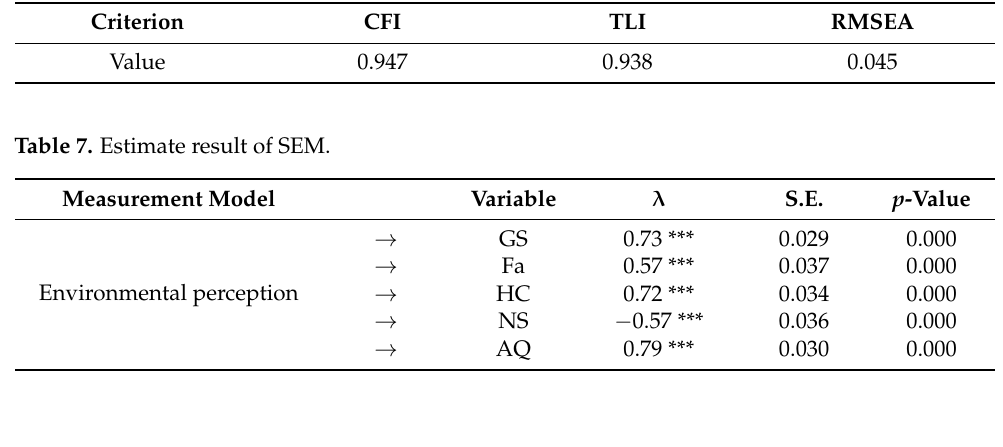
Table 6. Fit indices of SEM.